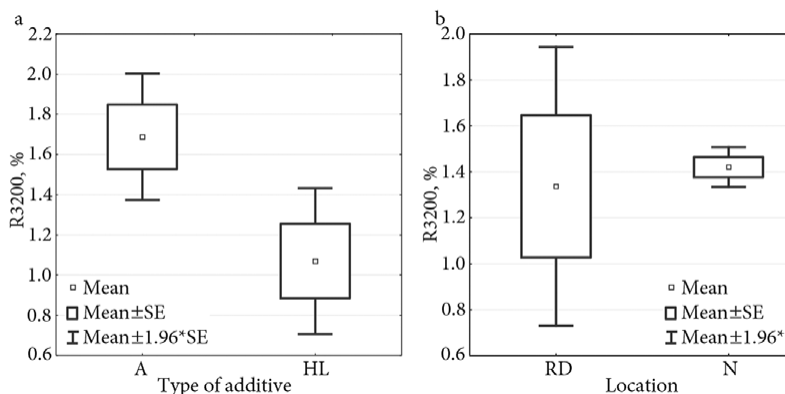
Fig. 13. Elastic recovery R3200 test results distribution at temperature 60 °C: a – additive; b –